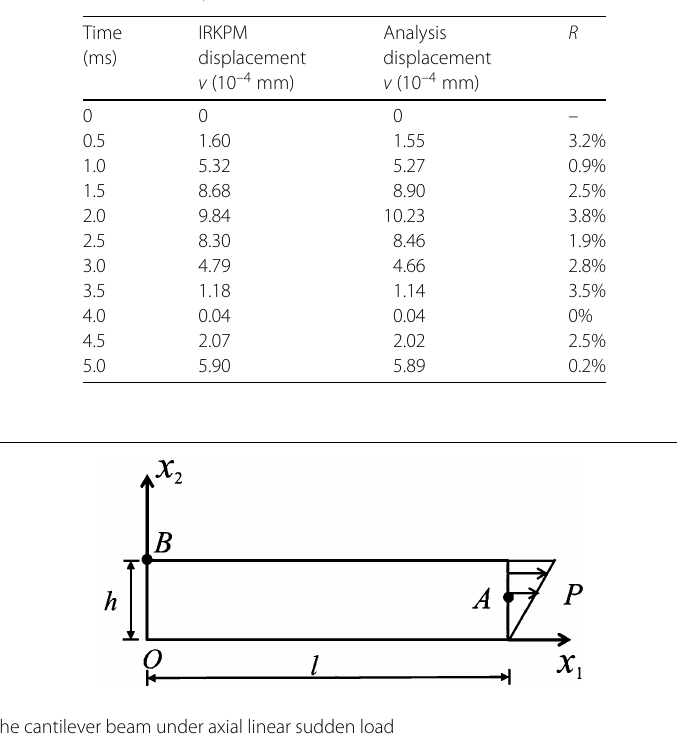
Table 1 The deflection of the midpoint of the free